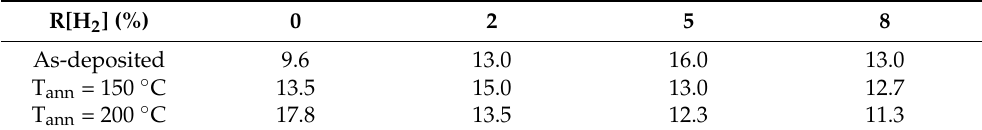
Table A2. Hall effect mobility (cm 2 /Vs) obtained by measurements of the IGZO and IGZO:H films before and after annealing for 1 h in ambient air at different temperature using a hot plate.